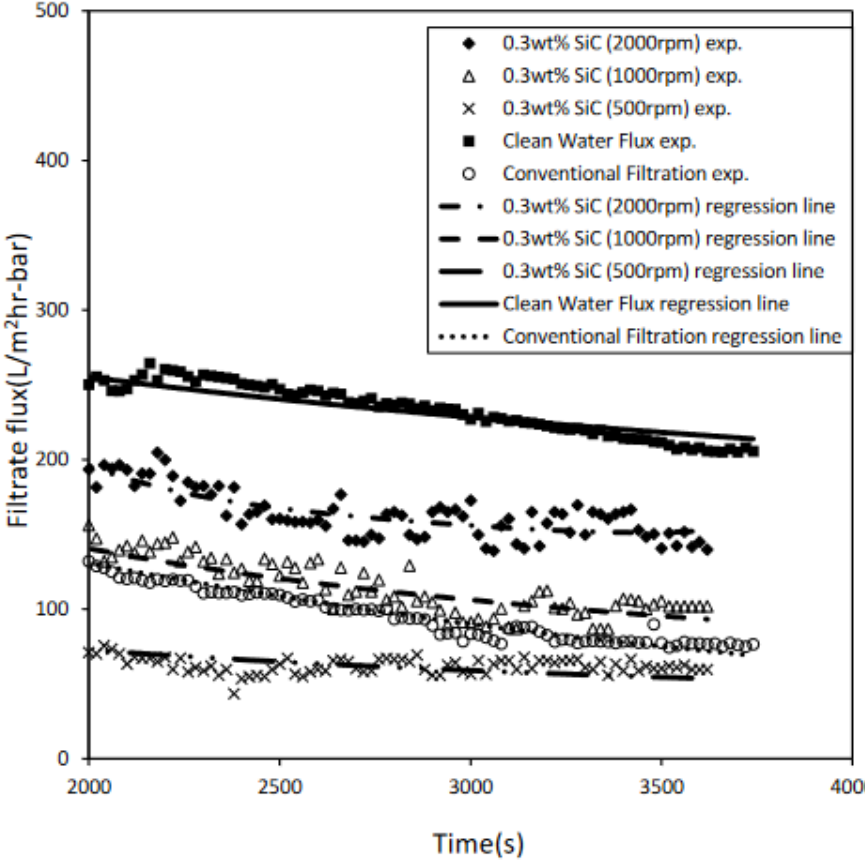
Figure 7. Filtrate flux rate at different centrifugal chamber rotation speeds.